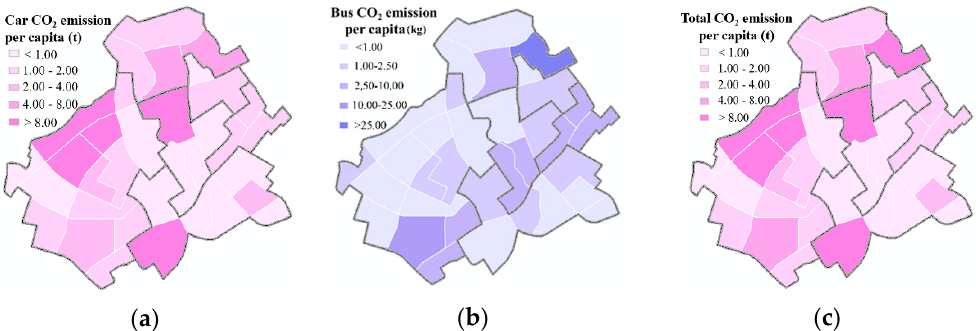
Figure 7. Spatial distribution of the sources of the per capita emissions of each TAZ. ( a ) Car CO 2 emission per capita; ( b ) bus CO 2 emission per capita; ( c ) total CO 2 emission per capita.